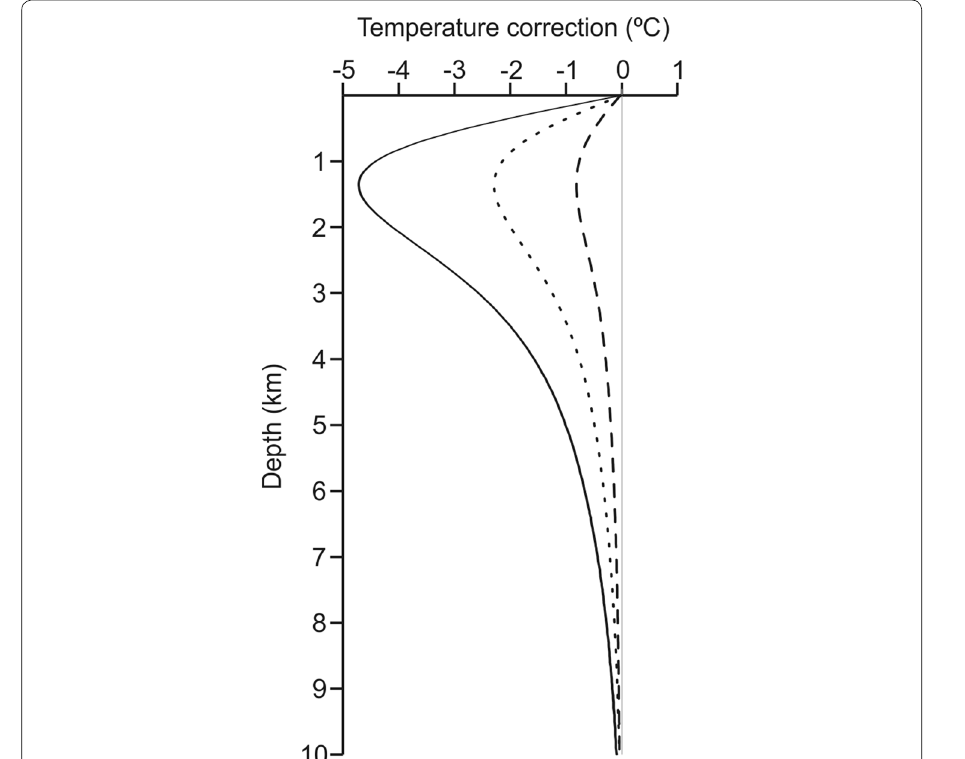
Fig. 8 Subsurface temperature perturbation caused by Pleistocene climate events. Solid line—temperature during glacial episode assumed as 10 °C colder than today; pointed line—temperature during glacial episode assume 5 °C colder than today; dashed line—temperature during glacial episode 1 °C colder than